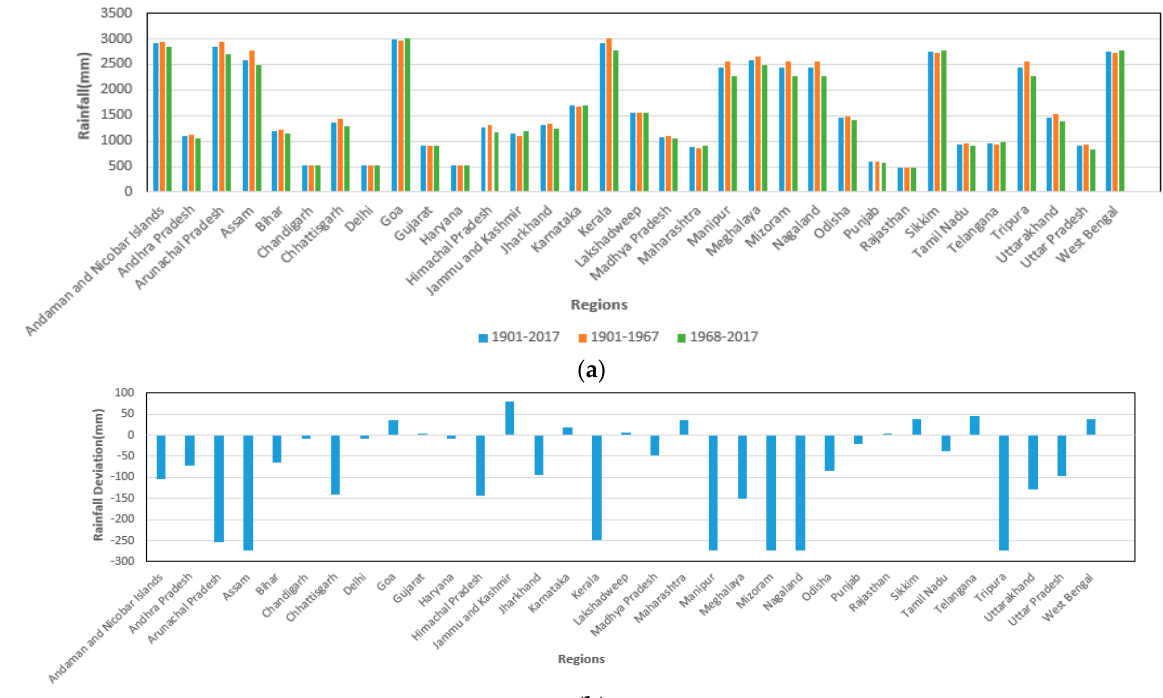
Figure 4. Rainfall comparison and deviation: ( a ) Comparison between rainfall for 117 years, first 67 years and recent 50 years, and ( b ) Deviation of rainfall in recent years.